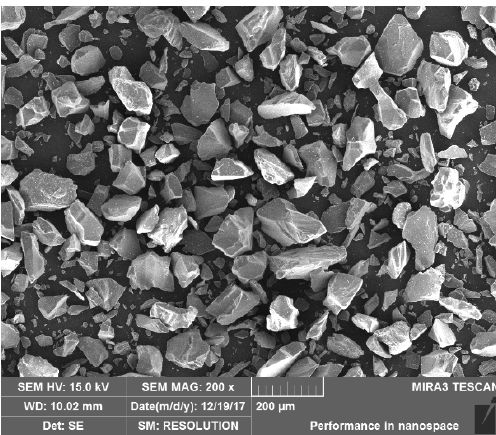
Figure 1. SEM micrographs of the erosion sand.